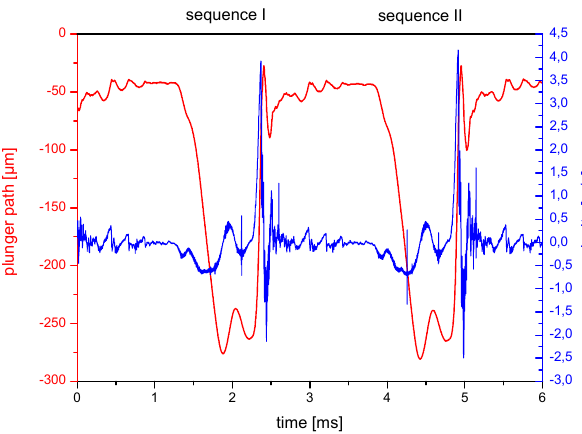
Figure 3. Laser vibrometer measurement of the linear plunger path as a function of time; parameters: